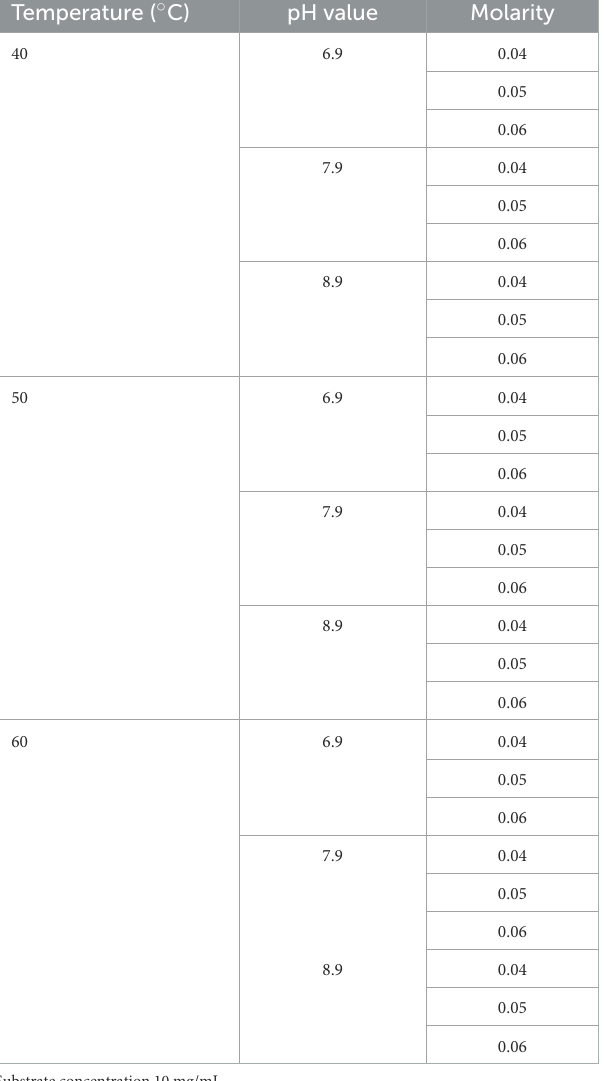
TABLE 4 Factorial design 3 3 to evaluate conditions for colloidal chitin hydrolysis to obtain N-Acetyl-glucosamine. Temperature ( ◦